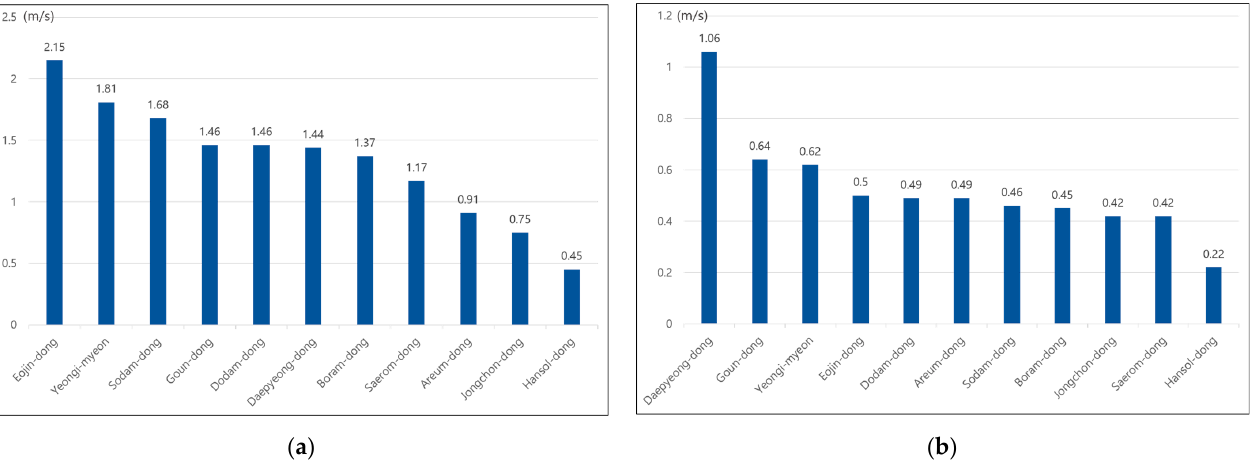
Figure 12. Comparison of speed of cold air flow by administrative districts at 360 min after the start of cold air generation: ( a) highest value of cold air flow; ( b ) average value of cold air flow.